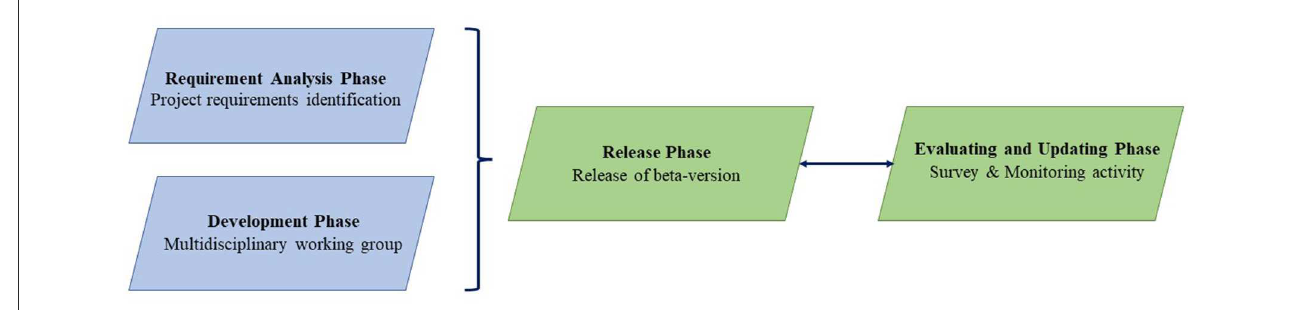
FIGURE1 The four distinct phases followed in order to develop the software.